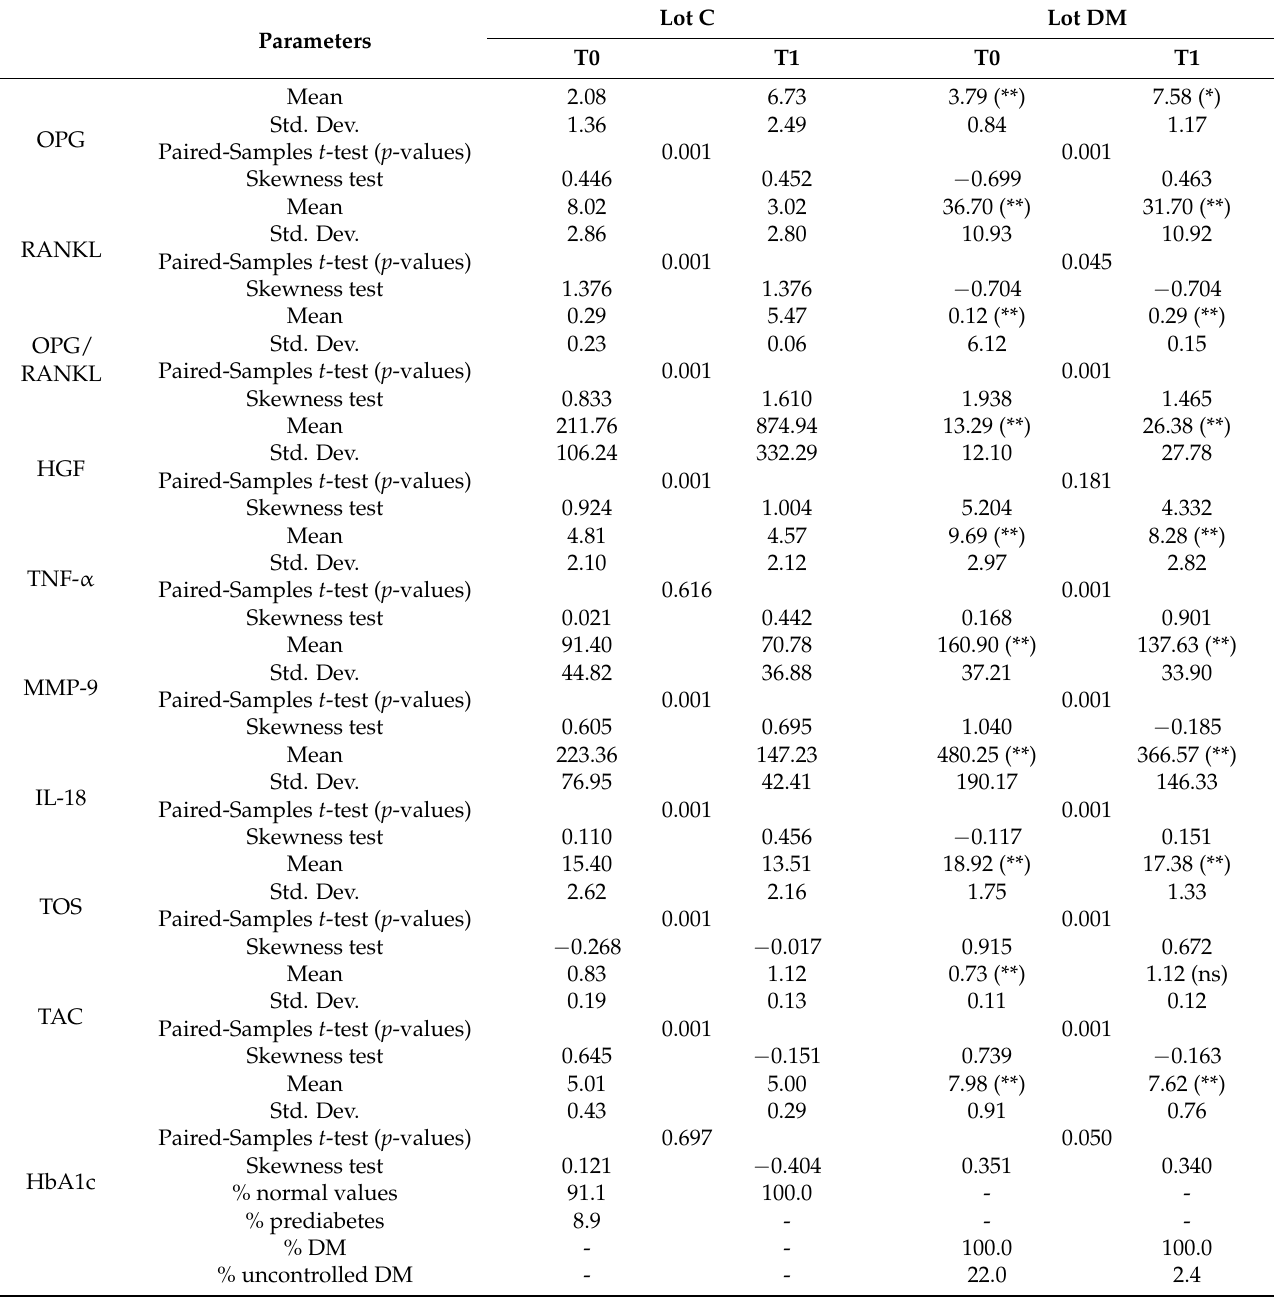
Table 2. Pre- and post-extraction OPG, RANKL, HGF, TNF- α , IL-18, MMP-9, TOS—total oxidant status, TAC—total antioxidant capacity, and HbA1c values in control and diabetes mellitus